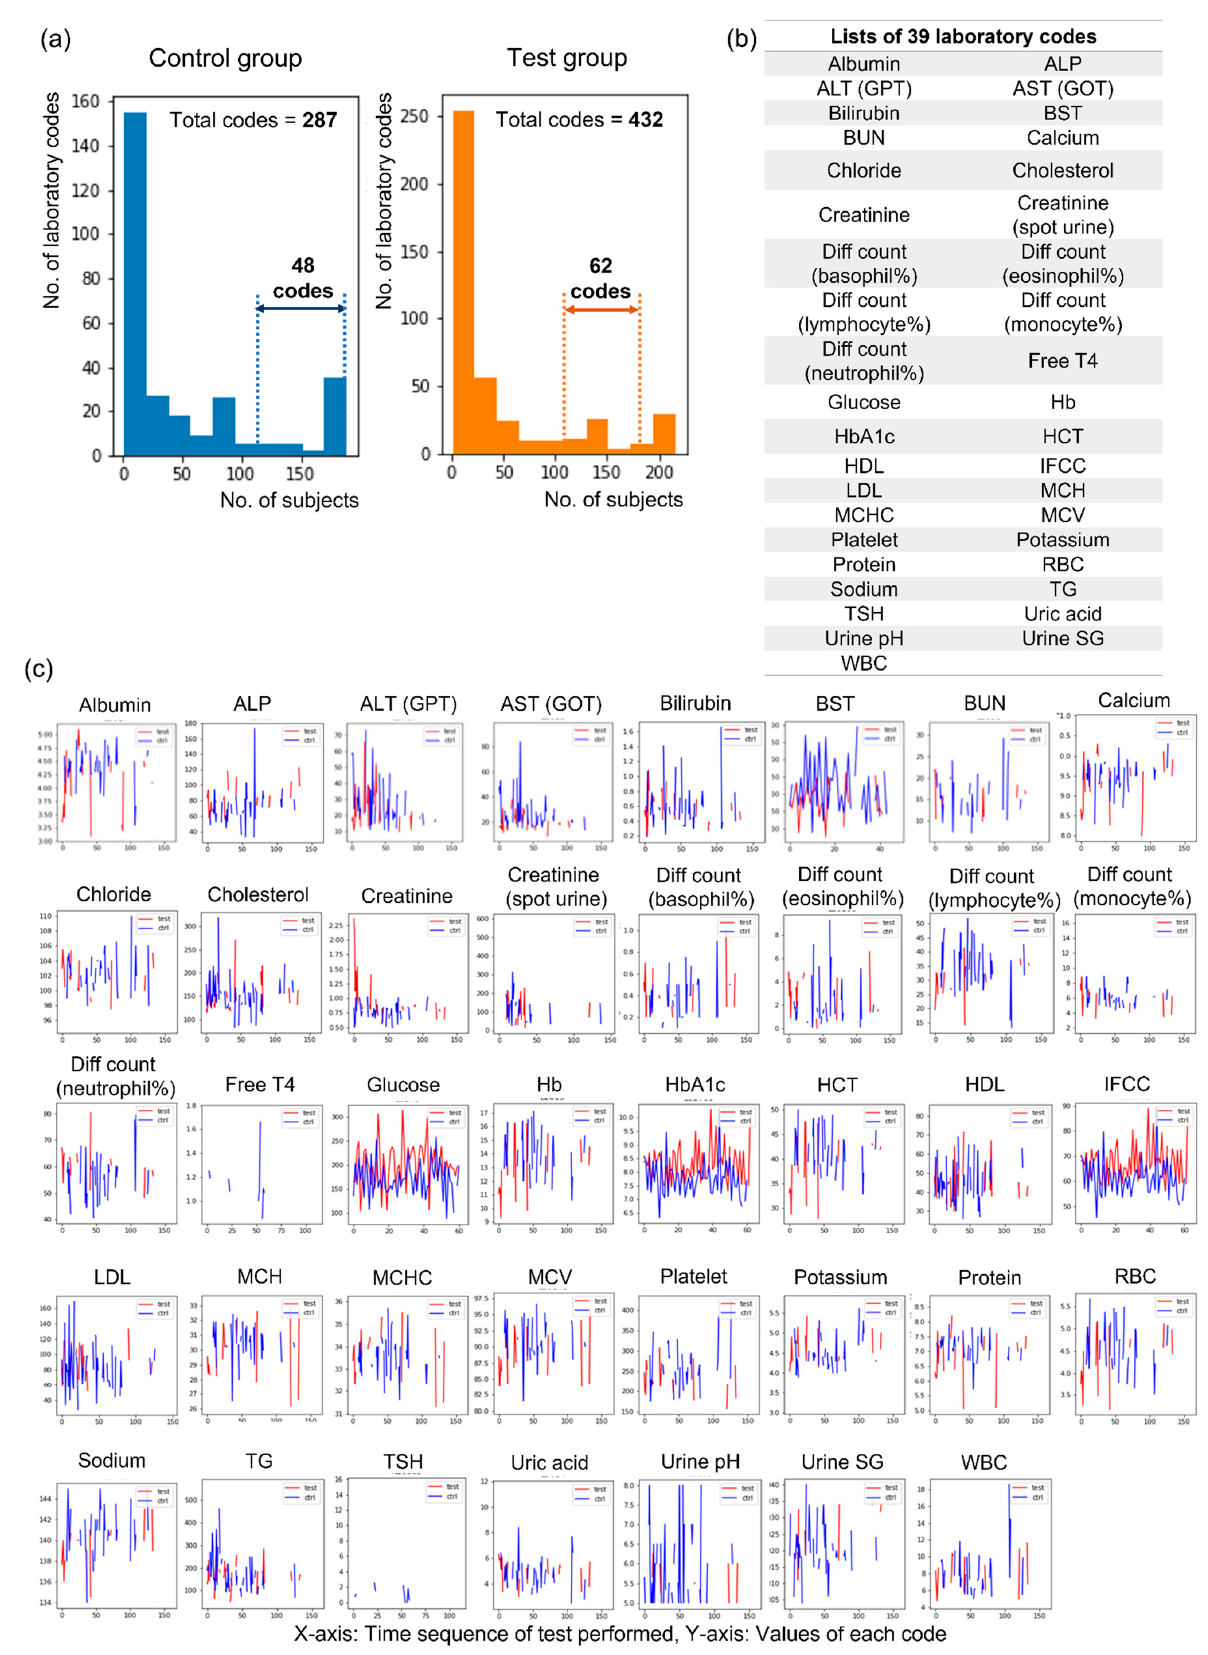
Figure 2. Selection of laboratory codes for machine learning analysis. ( a ) The distribution of laboratory codes according to tested subject numbers in the control and test groups, ( b ) lists of 39 selected laboratory codes, ( c ) graphs showing the